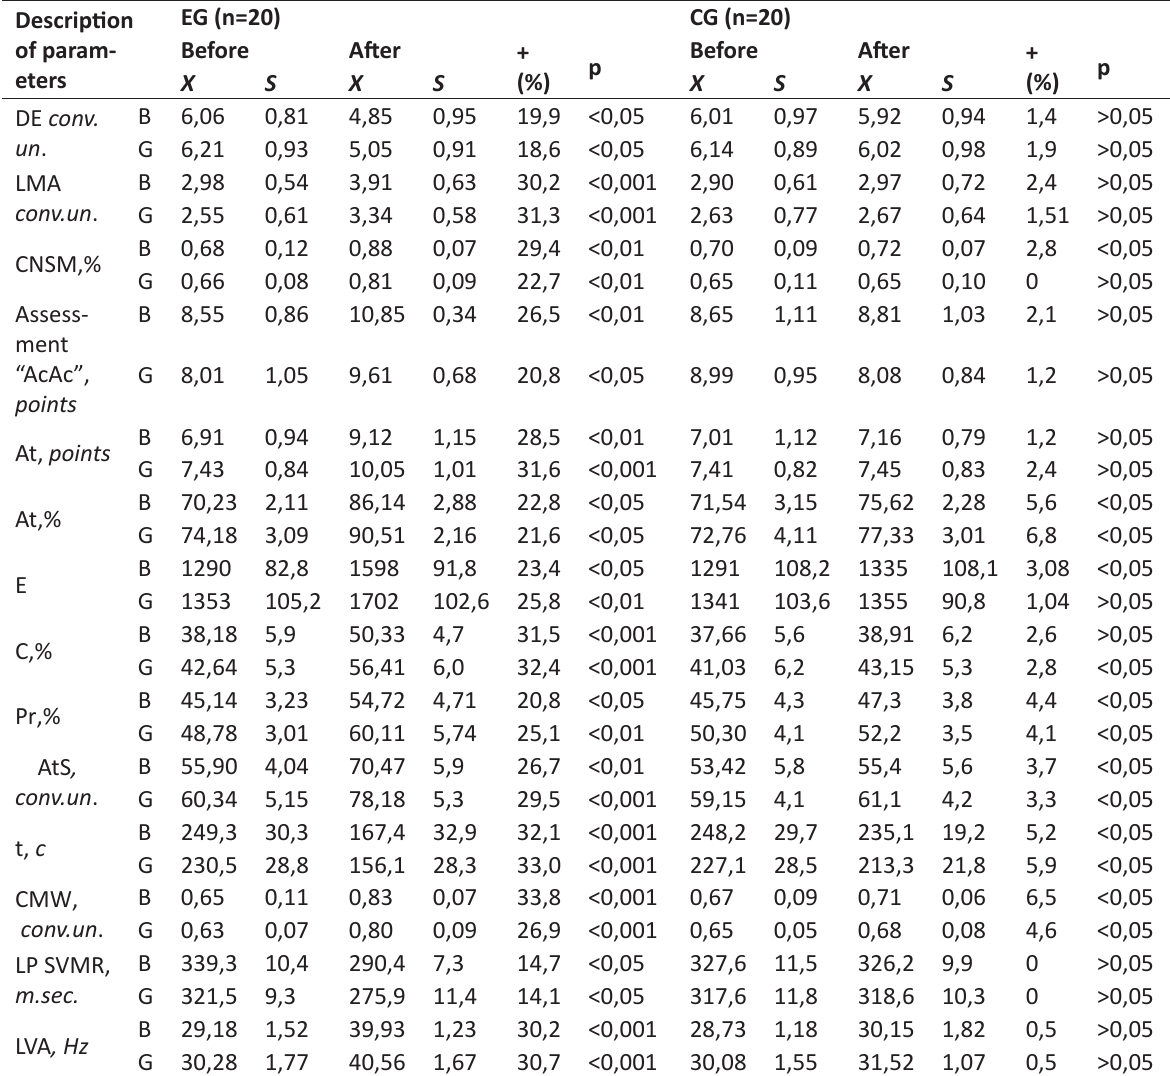
Table 2. Indicators of psycho-physiological functions parameters of students with ophthalmologic diseases after experiment Description